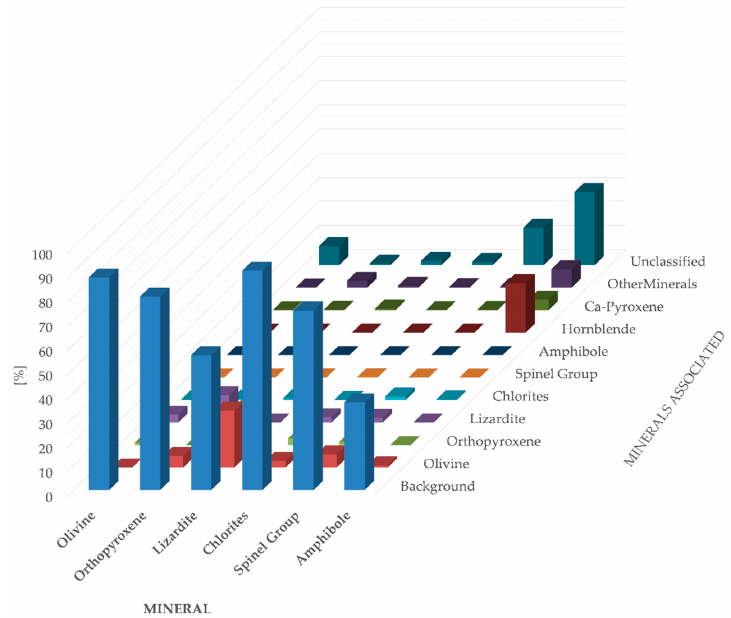
Figure 1. Mineral Association of the used olivine bearing ore (QEMSCAN©).